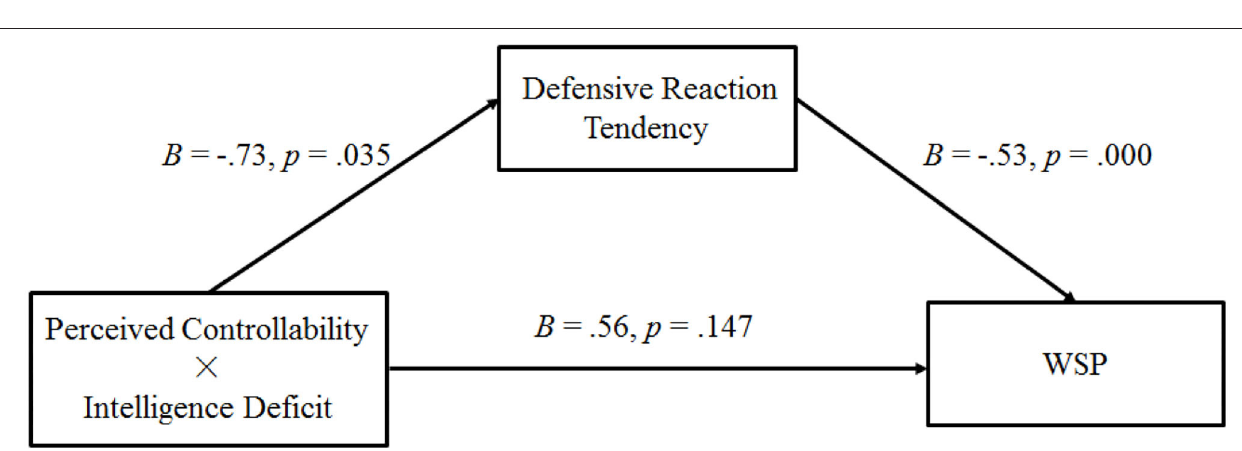
FIGURE 2 | Results of Experiment 1: willingness to purchase self-improvement products (WSP) as a function of intelligence deficit and perceived controllability.